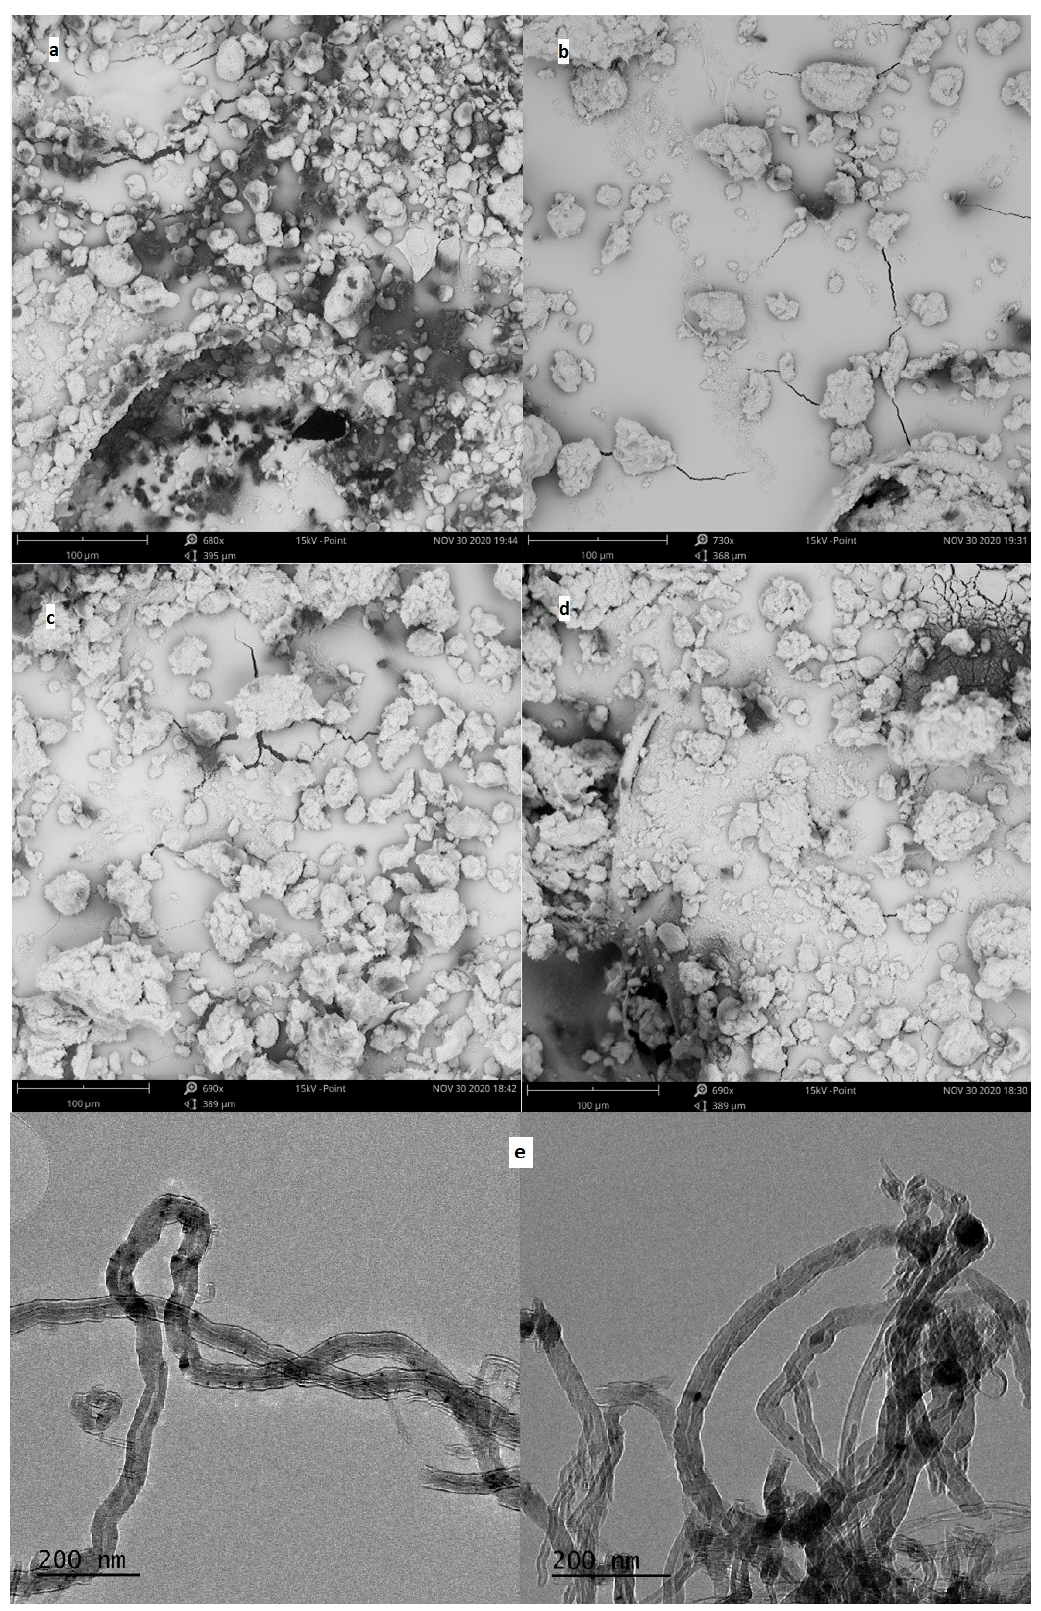
Figure 3. The SEM images of MWCNT powder for ( a ) MWCNT-COOH, ( b ) MWCNT-COO-Co, ( c ) MWCNT-COO-Mn, and ( d ) MWCNT-COO-Cu and ( e ) TEM images of MWCNT-COO-Co.